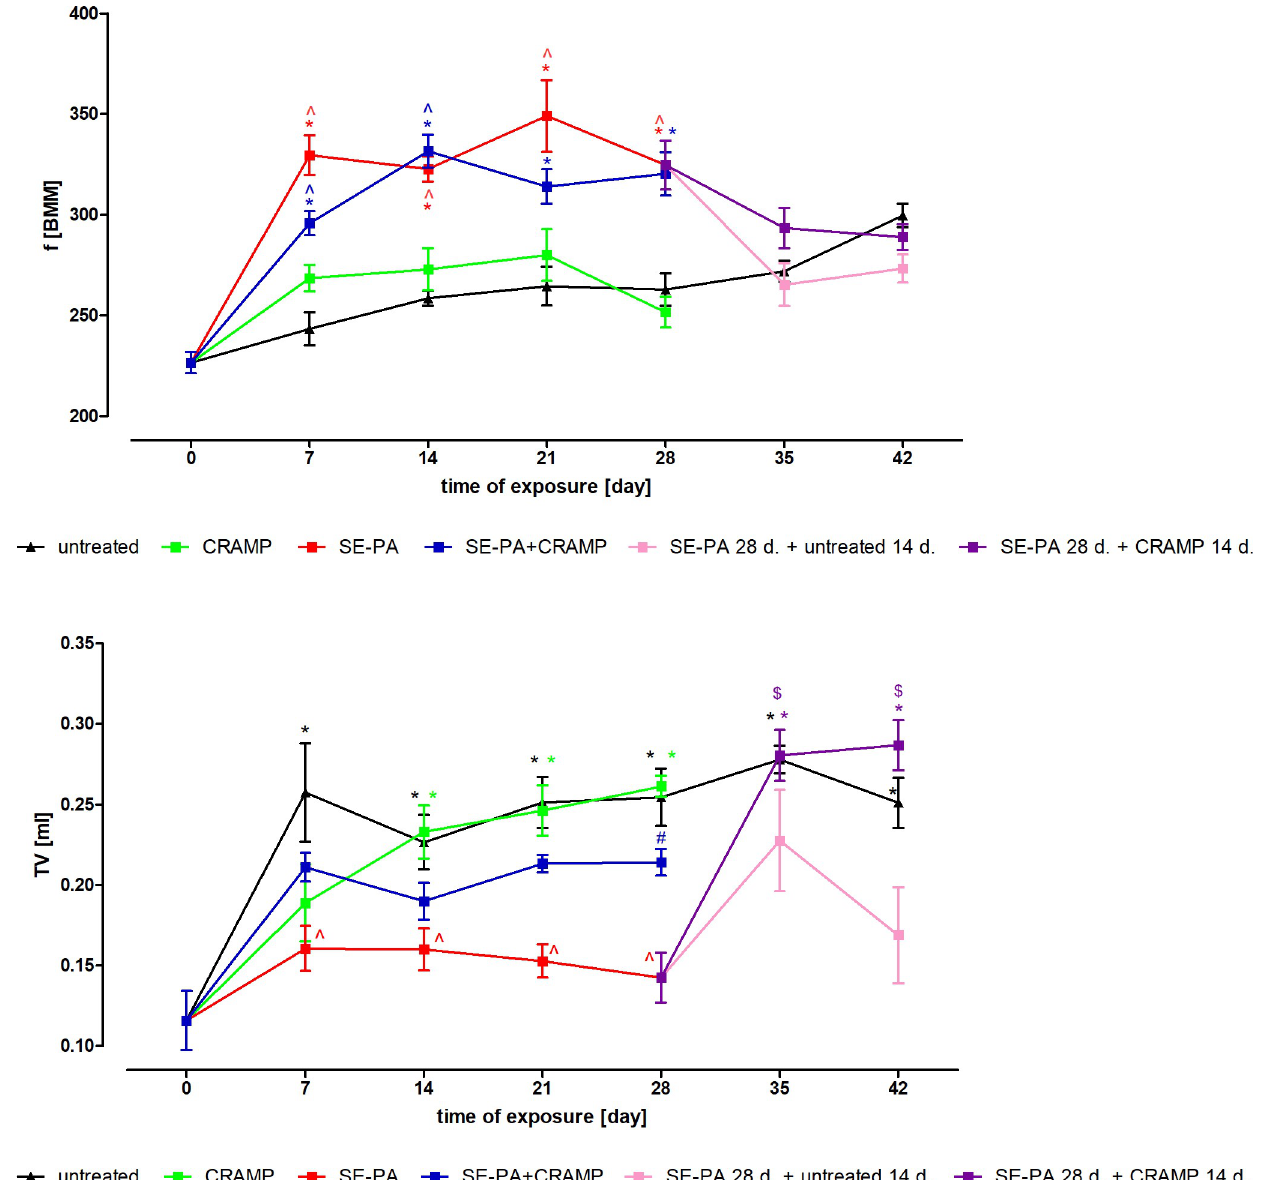
Fig 6. Changes in mouse pulmonary function in response to cathelicidin (CRAMP) and/or Saline Extract of Pantoea Agglomerans (SE-PA) treatment. The frequency of breathing (f) and tidal volume (TV) was investigated before treatment and after every 7 days of mice exposure to investigated compounds. The data were collected every 2 s for 15 min. The data are presented as a mean of tested ventilatory parameters ± SEM. Each research group contained 8 mice: 6 treated and 2 untreated animals. A pulmonary function test was conducted in all animals. � p < 0.05 vs. untreated; ^ treated vs. untreated (comparison within corresponding time points); # p < 0.05 SE-PA+CRAMP vs. SE-PA (comparison within corresponding time points); @ p < 0.05 SE-PA 28 d. + CRAMP 14 d. vs. SE-PA 28 d. + untreated 14 d. (comparison within corresponding time points); $ p < 0.05 SE-PA 28 d. + CRAMP 14 d./ SE-PA 28 d. + untreated 14 d vs. SE-PA (day 28). One-way ANOVA test; Tuckey post-hoc test.